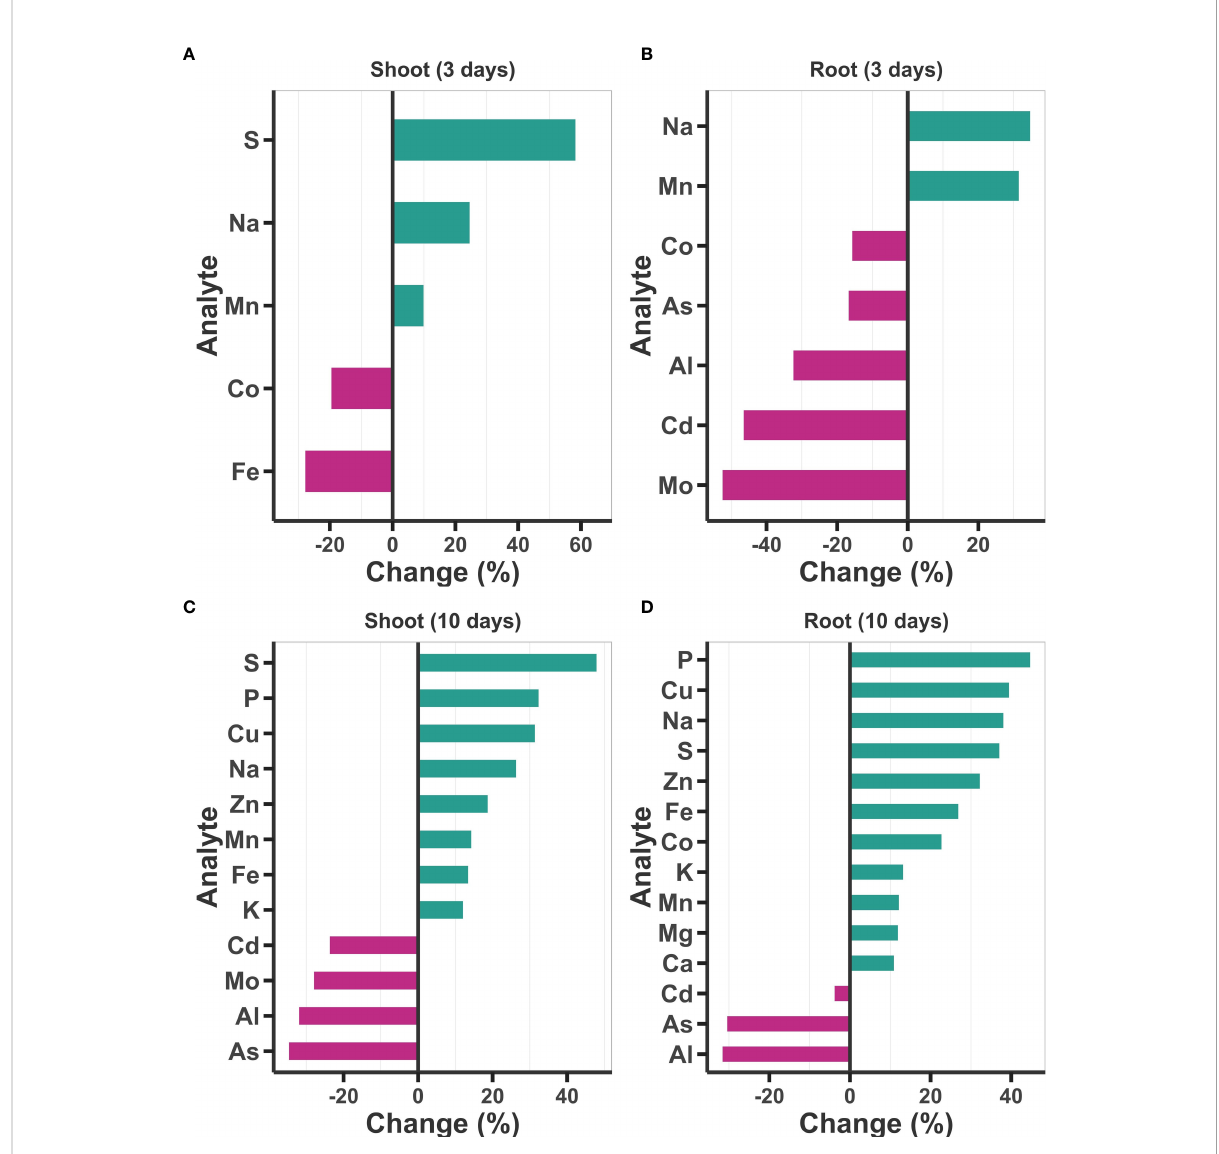
FIGURE 3 Effect of Titanium (Ti) on elemental content of Arabidopsis. Content (mg of the analyte/kg of the sample) of 19 elements was determined in shoot and root three days (A, B) and 10 days (C, D) after the treatment with Ti 2 mM. Only elements with statistically signi fi cant changes according to Tukey ’ s signi fi cance test ( p< 0.05) are presented. Changes are presented as percentage